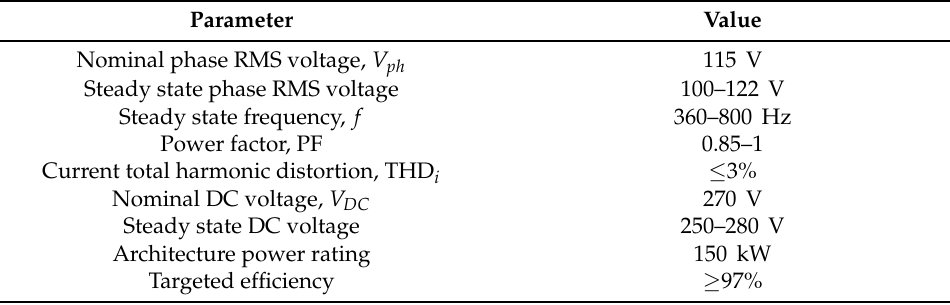
Table 1. Application requirements and future